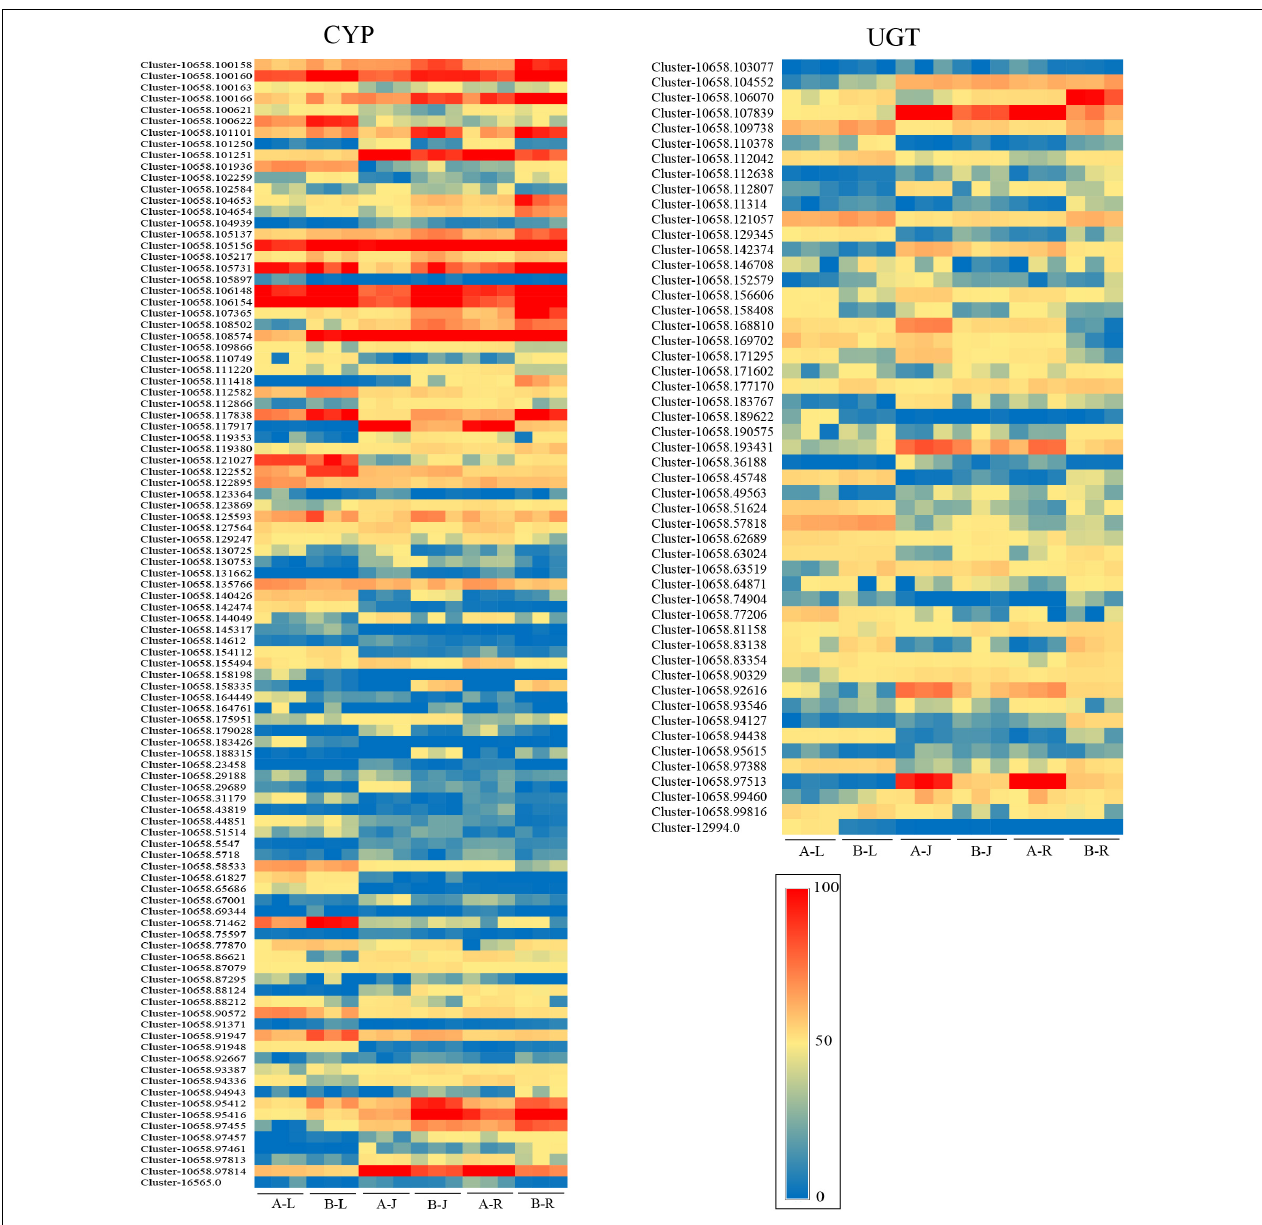
FIGURE 6 | Expression levels of CYP and UGT transcripts in P.